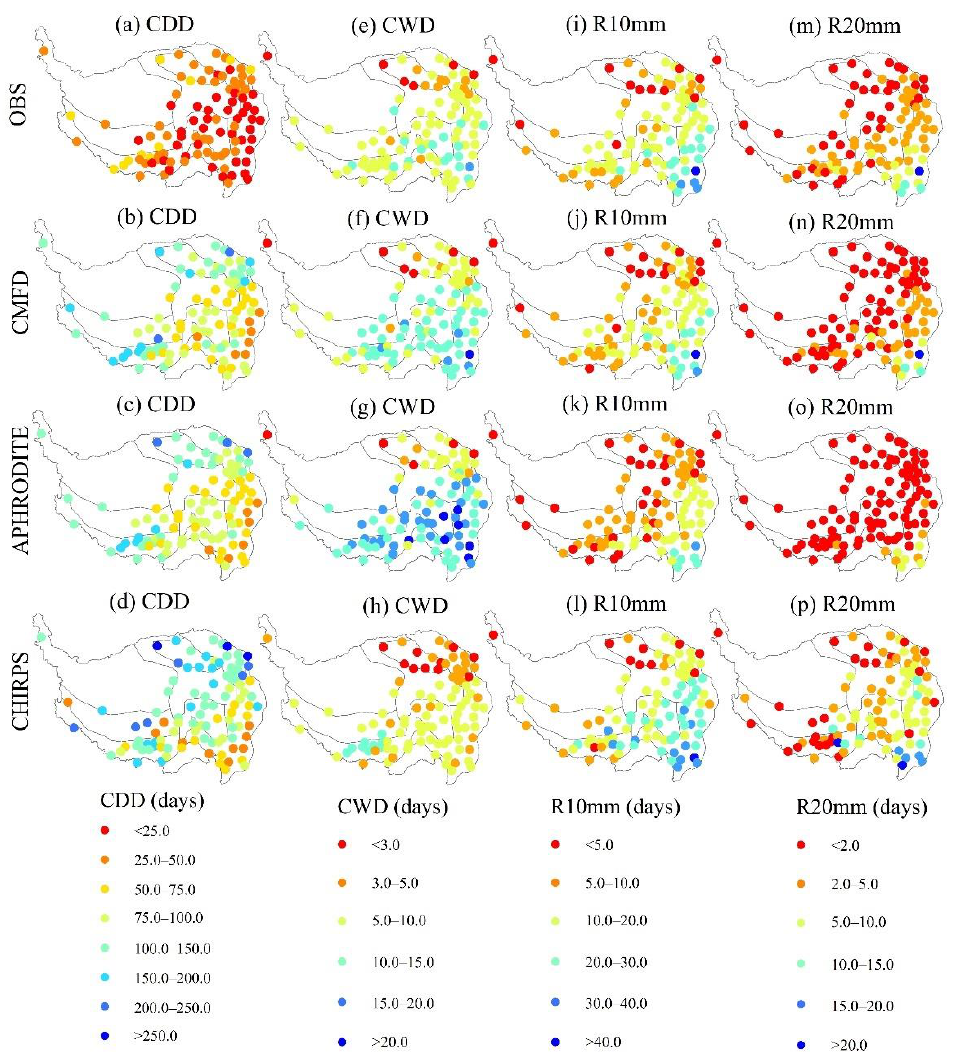
Figure 2. Mean spatial distribution of fixed threshold indices from 1981 to 2014: CDD, CWD, R10mm, and R20mm.